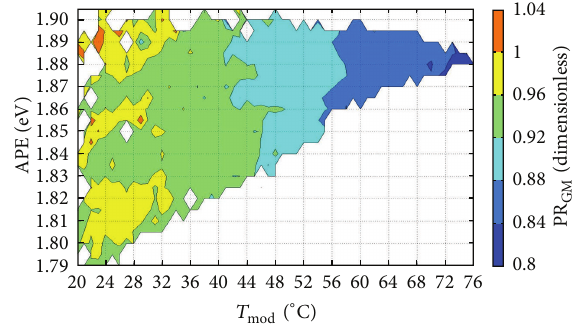
Figure 5: Contour graph of PR GM of the tested CdTe PV module as a function of 𝑇 mod and APE. Blank areas indicate no data